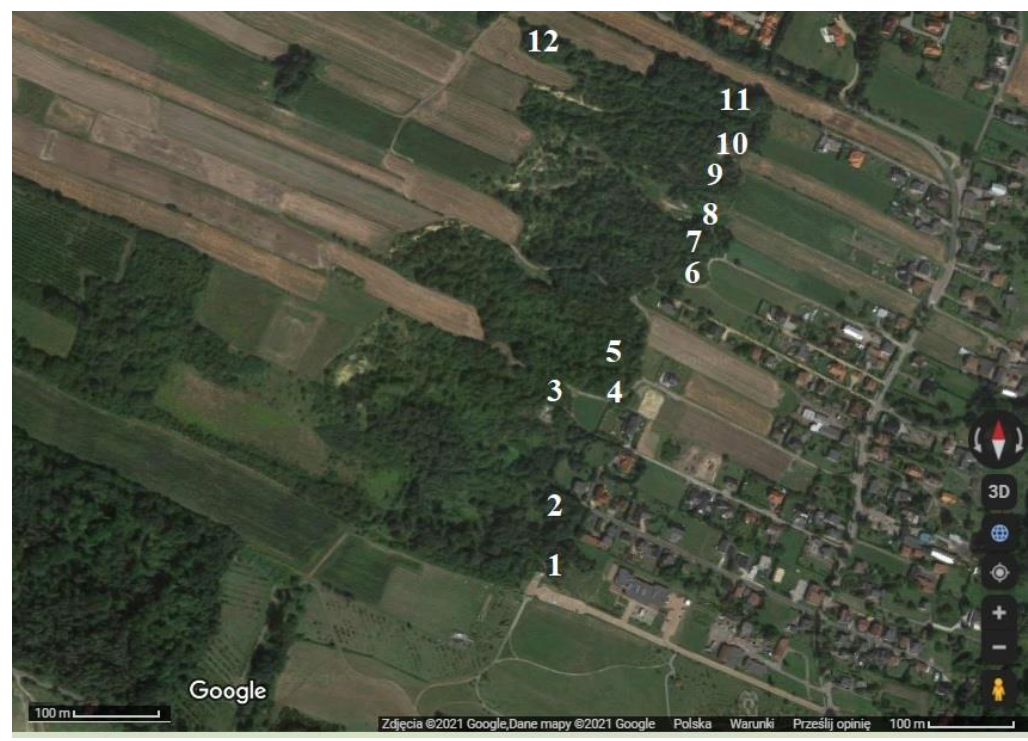
Fig. 6. Location of lime kilns in Mikołów Mokre. Explanations: 1, 2, … - 12 – numbers of lime kilns corresponding to the numbering in Table 1 (Note: Lime kiln no. 13 is located approx. 550 meters to the north-west of lime kiln no. 12, while lime kiln no. 14 is located approx. 1900 meters west-south-west from lime kiln